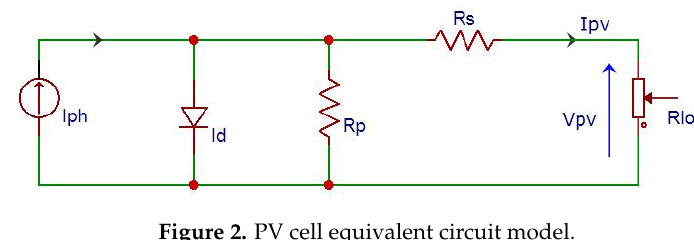
Figure 2. PV cell equivalent circuit model.